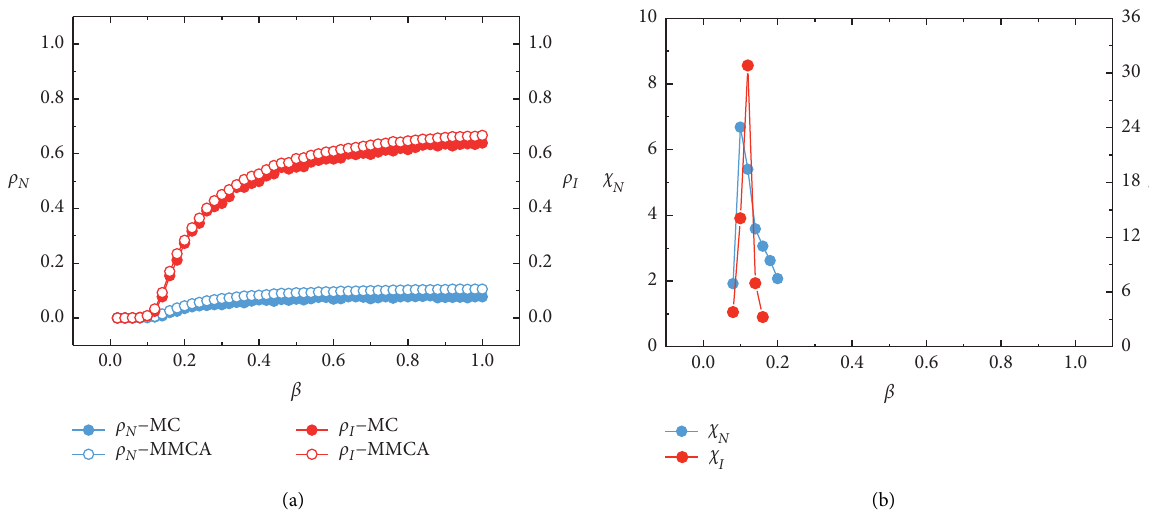
Figure 3: (a) The final fractions ρ I and ρ N of the infected nodes and the noresource nodes as a function of epidemic transmission rate β . The blue circle indicates ρ N and the red circle indicates ρ I . For both ρ I and ρ N , we present the results of numerical simulation and MMCA approach in full and open circles, respectively, which are in good agreement with each other. (b) The variability χ of ρ I and ρ N as a function of β . We can determine the critical points of ρ I and ρ N by the peak of variability and obtain the outbreak threshold of epidemic spreading β c � 0 . 12. The other fixed parameters are δ � 0 . 10, λ � 0 . 64, μ � 0 . 48.